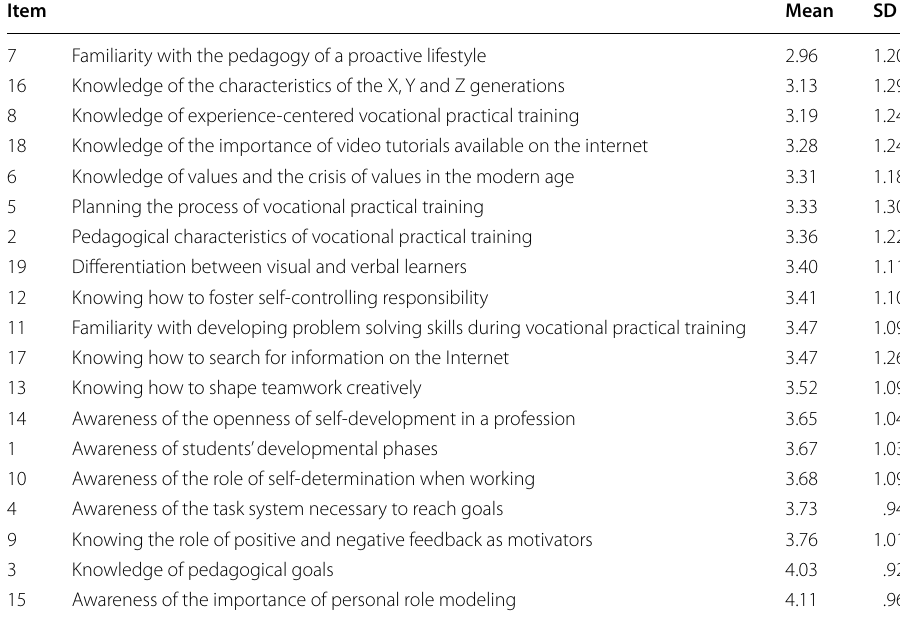
Table 2 Items on being prepared for the teaching profession as judged by vocational edu- cation